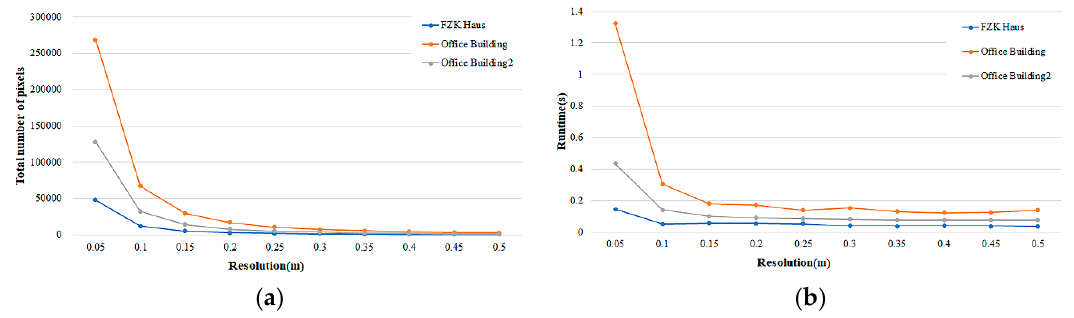
Figure 19. Statistical result of the indoor adjacency extraction algorithm at different models in terms of total number of pixels ( a ) and runtime ( b ).